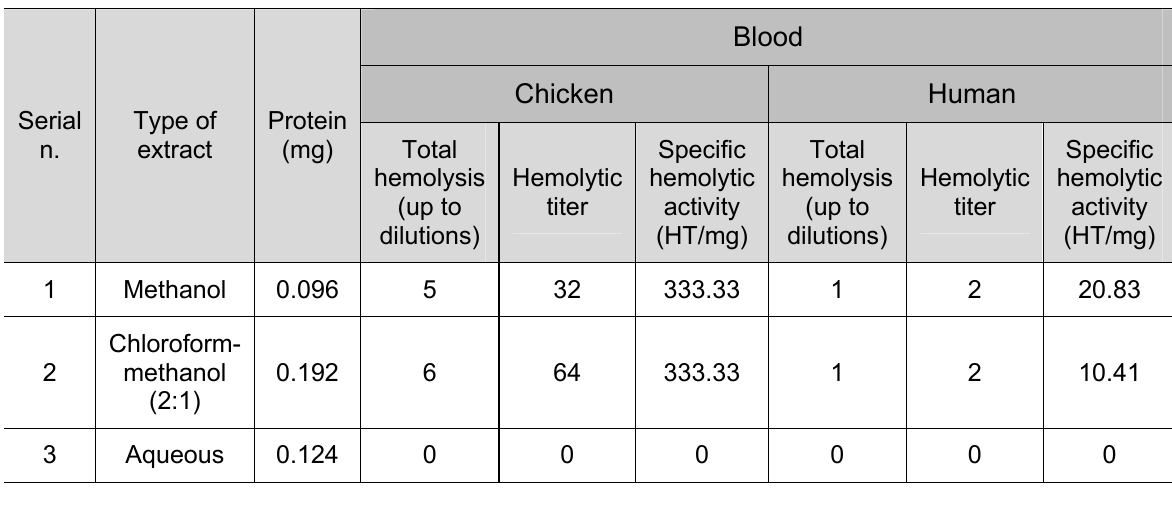
Blood Chicken Human